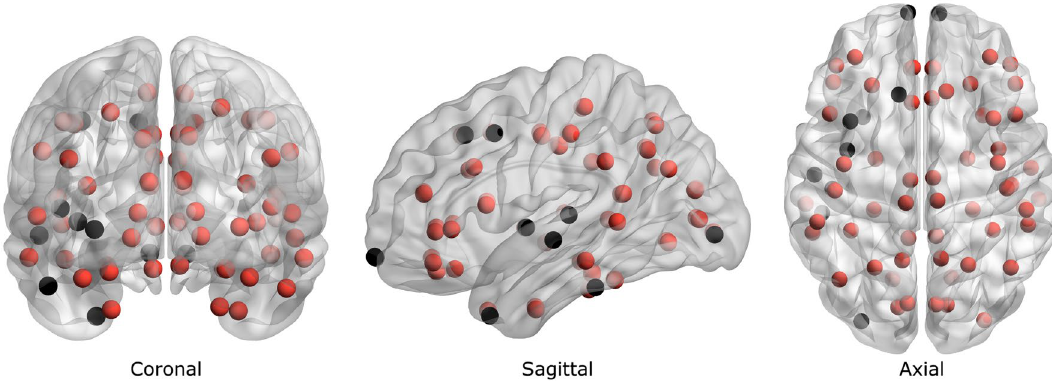
Figure 2. Brain model representing localizations of each ROI according to the Desikan-Killiany atlas. Red balls represent ROIs that showed statistically significant differences in beta RP values between AD patients with risk and protective PICALM and CLU alleles (FDR-corrected p -value < 0.05, Mann–Whitney U